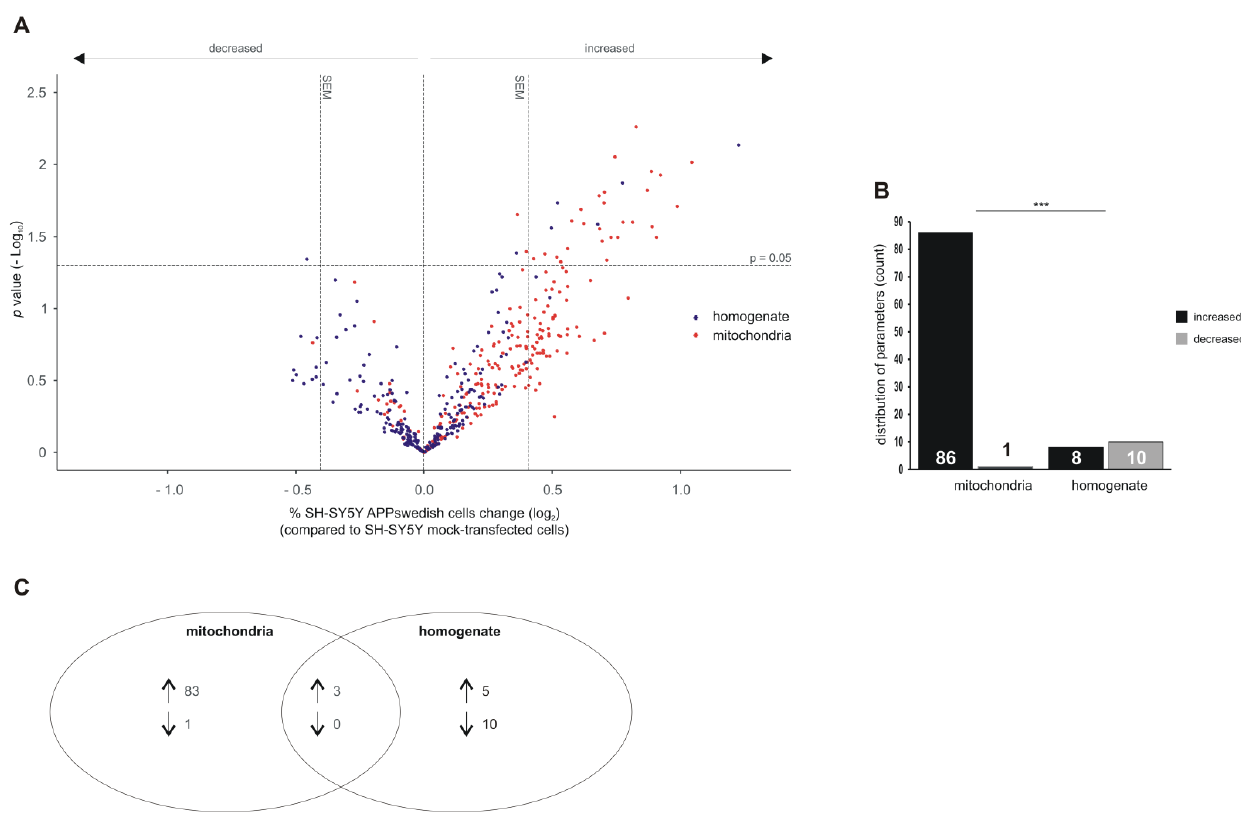
Figure 2. Lipid changes in homogenates and mitochondria of SH-SY5Y APPswedish cells in comparison to mock-transfected SH-SY5Y cells, respectively. ( A ) The fold changes of 226 lipid species were plotted logarithmically against the p value (-Log10) for homogenates (blue) and mitochondria (red). Vertical dashed lines next to 0 represent the average SEM and the horizontal dashed line marks p = 0.05. ( B ) Distribution of lipid species with a fold change greater than the average SEM and a p value ≤ 0.05 represented as number of decreased and increased lipid species in homogenate and mitochondria in a bar chart. Statistical significance was calculated using Fisher’s exact test with *** p ≤ 0.001. ( C ) Venn diagram showing the number of exclusively changed as well as overlapping lipid species in mitochondria and homogenates in SH-SY5Y APPswedish cells compared to mock-transfected cells. Arrows indicate decreasing ( ↓ ) or increasing ( ↑ ) effects.